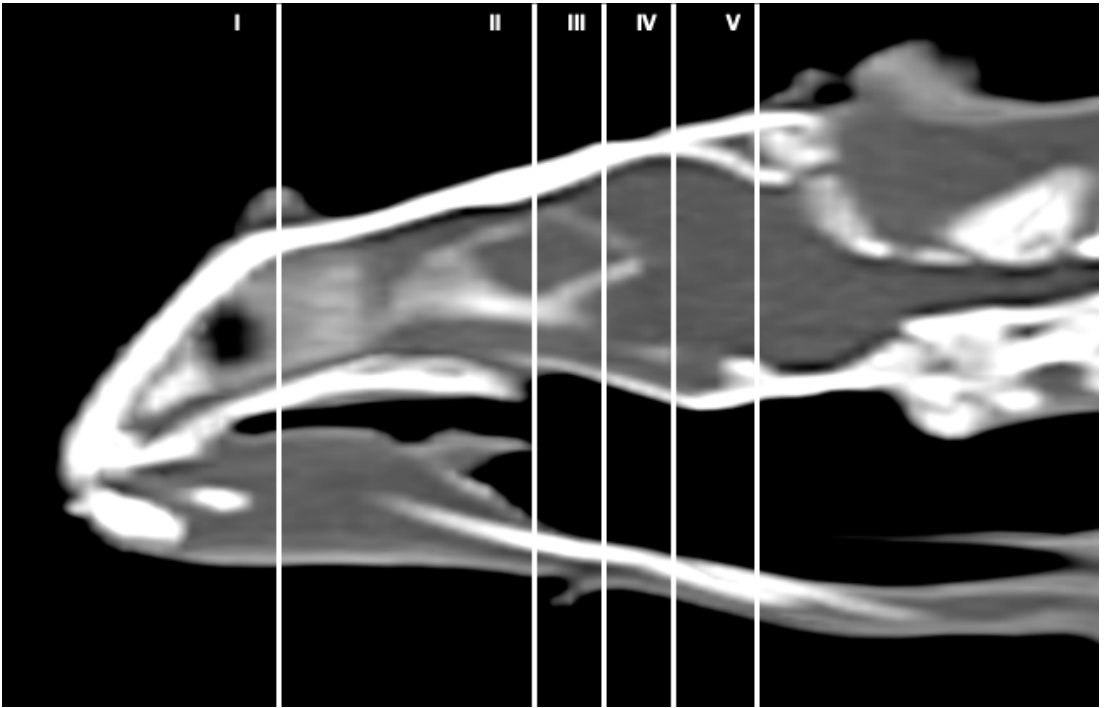
Figure 1. Sagittal CT bone window image of the head of rhinoceros iguana that approximately representing the level of the slices of this study. Segments I–V correspond to Figures 2–6.